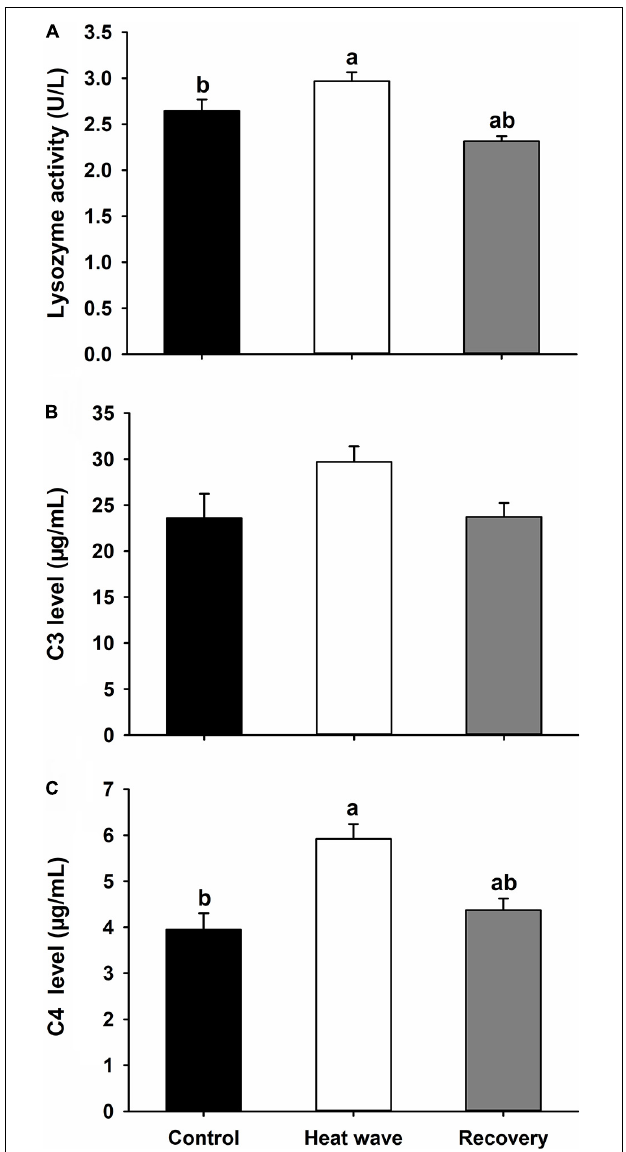
FIGURE 4 | Effects of heat wave on the lysozyme activity (A) , C3 level (B) , and C4 level (C) of Mauremys mutica. Data were represented as mean ± standard error (SE).